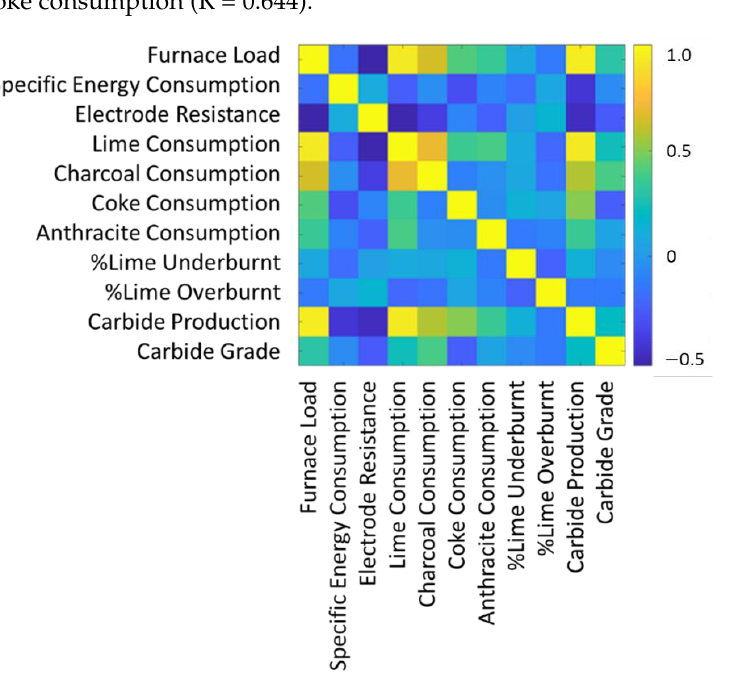
A color-coded image of the correlation matrix of the predictor and target variables is